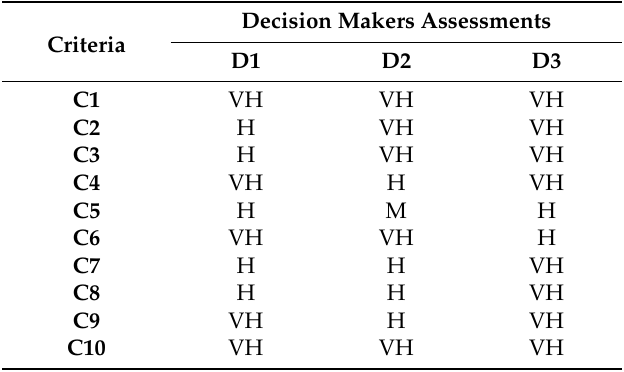
Table 5. Importance weight of criteria from three